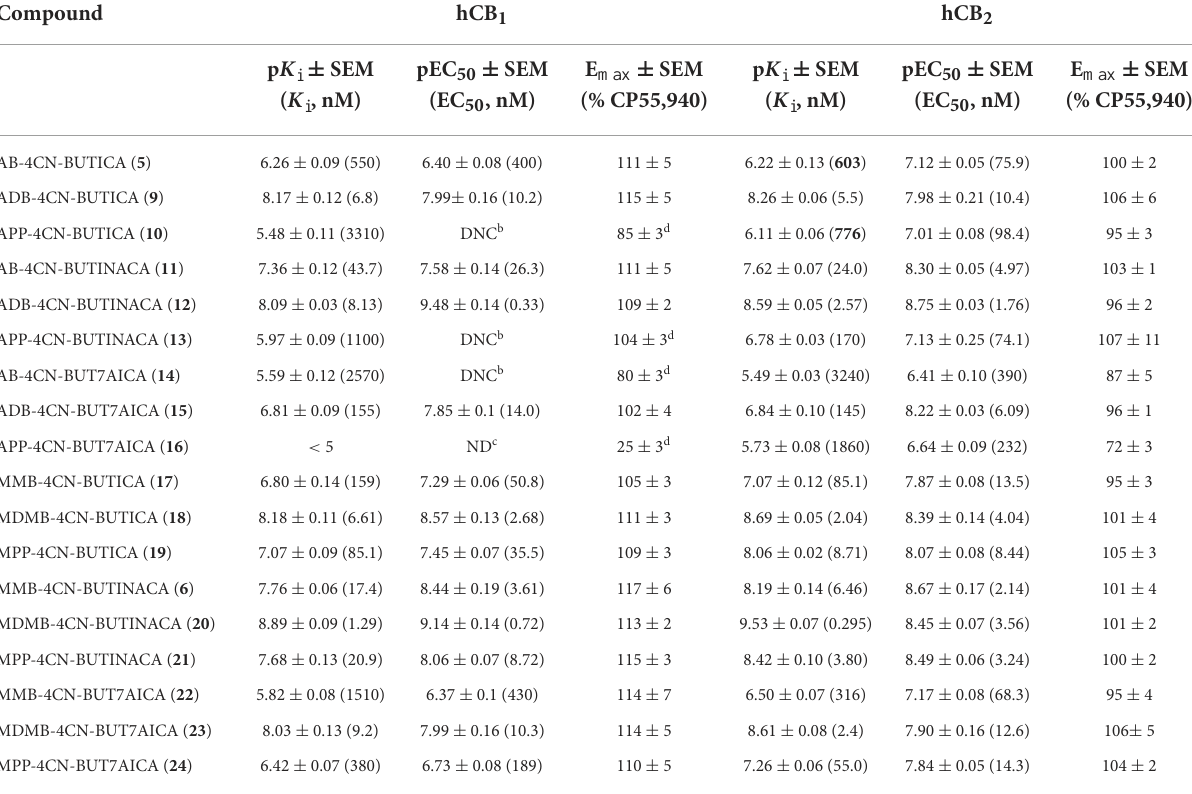
TABLE 1 Affinities and functional activities of 4-cyanobutyl derived SCRAs at hCB 1 and hCB 2 .